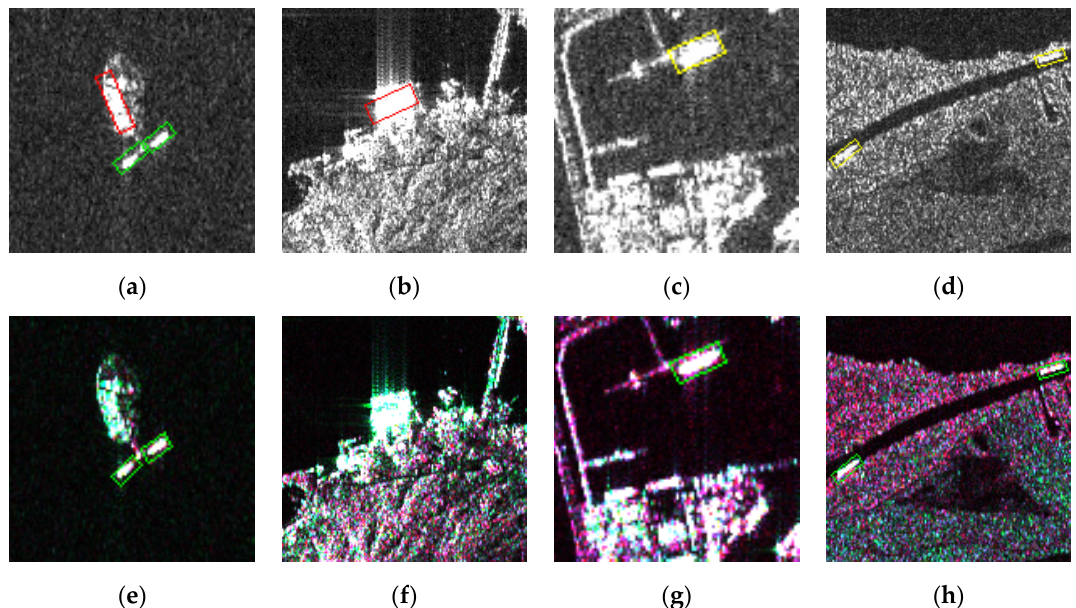
Figure 12. Comparison of RBox detection results on single-polarimetric images ( a – d ) and pseudo-color enhanced images ( e – h ) of DSSDD.